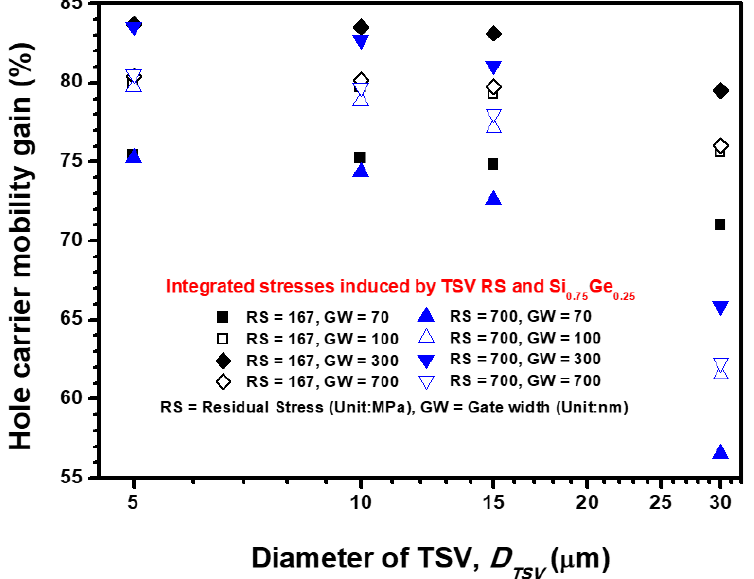
Figure 11. Comprehensive hole carrier mobility gain variation in the S/D lattice-strained Si pMOSFET.